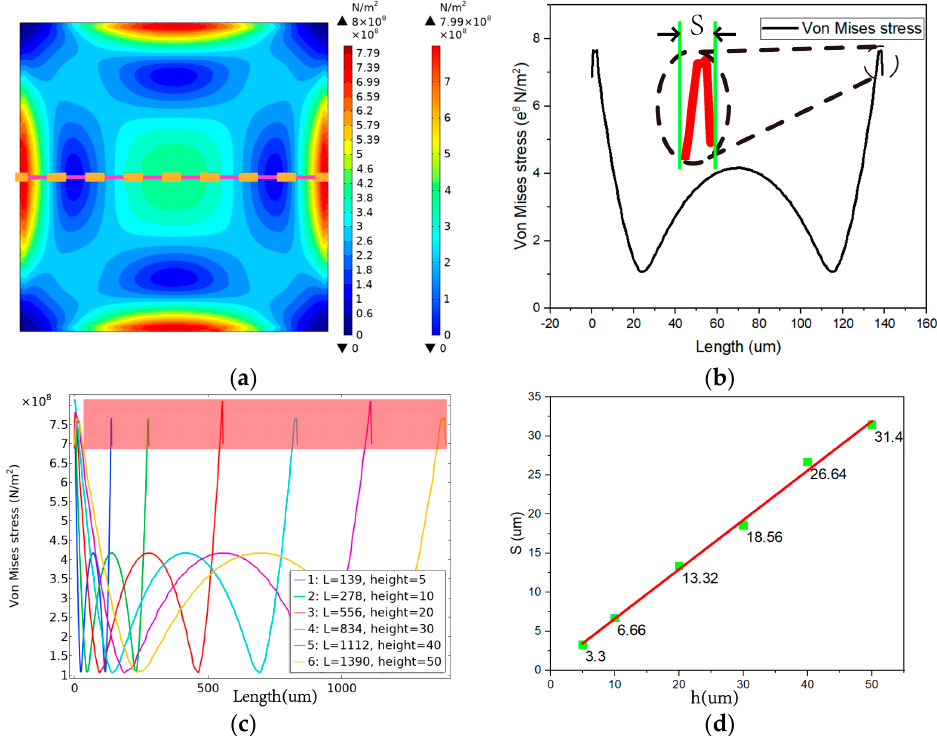
Figure 4. ( a ) Sensitive diaphragm stress distribution; ( b ) optimal stress length S ; ( c ) centerline stress distribution; ( d ) relationship between the thickness of the sensitive diaphragm and the length S of the stress